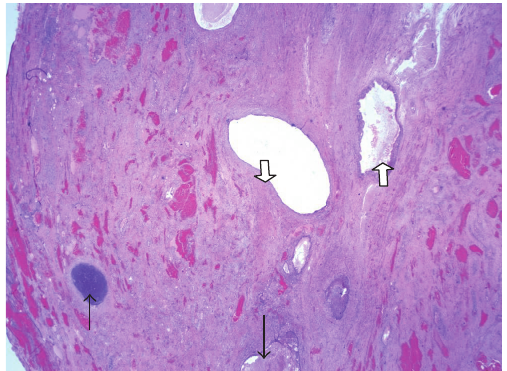
Figure 5: Photograph showing histological features of teratomatous components. Upward black head arrow: mature cartilage. Upward white arrow: respiratory epithelium. Downward black head arrow: squamous epithelium with keratin cyst. Downward white arrow: columnar epithelium with goblet